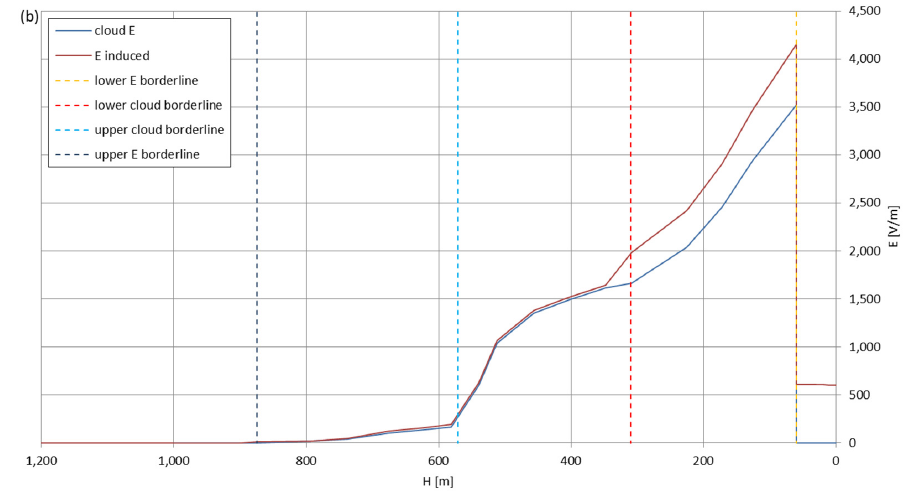
Figure 16. Maximum electric field strengths around the wire antenna re-entering through Stratocumulus cloud charged negatively: ( a ) ‘static’ case and ( b ) ‘dynamic’ case.